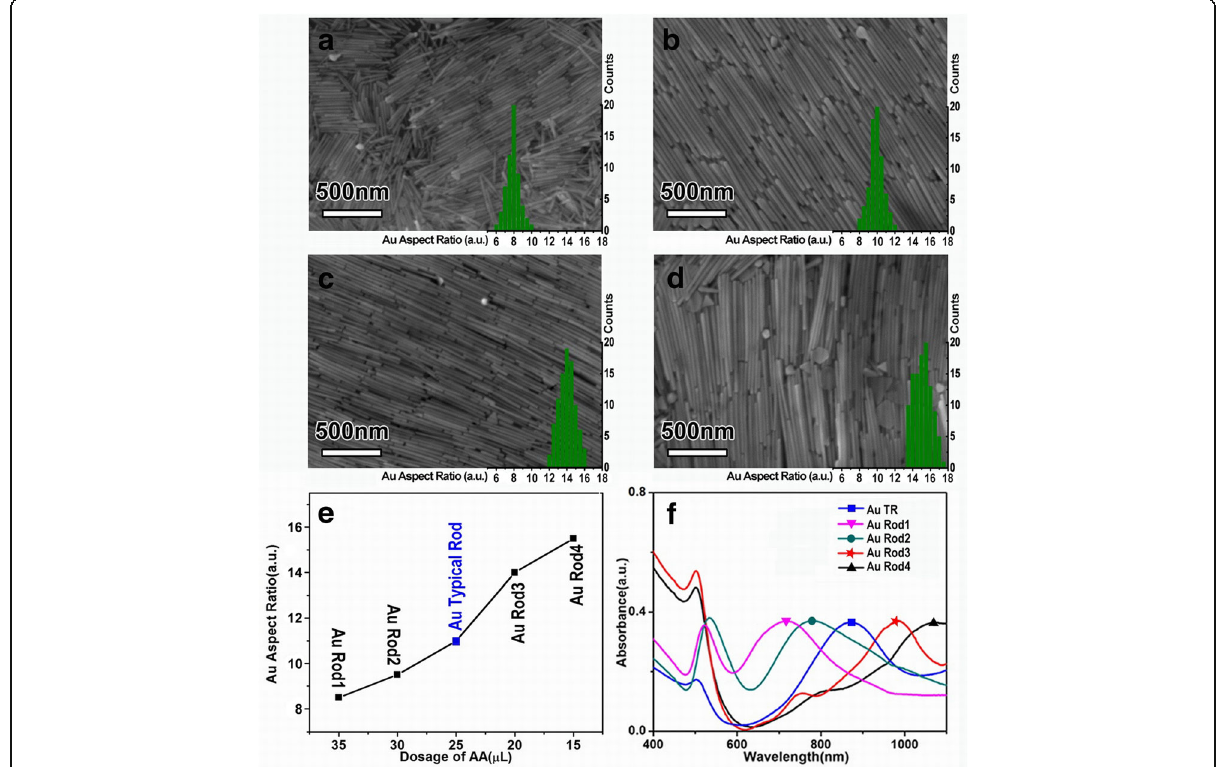
Fig. 2 Morphology and aspect ratio statistics of AuNRs with different AA dosages: a – d SEM and histogram, a Rod1, b Rod2, c Rod3, and d Rod4. e The line chart of AA dosage corresponding to the aspect ratio. f The UV-vis absorption spectra of different